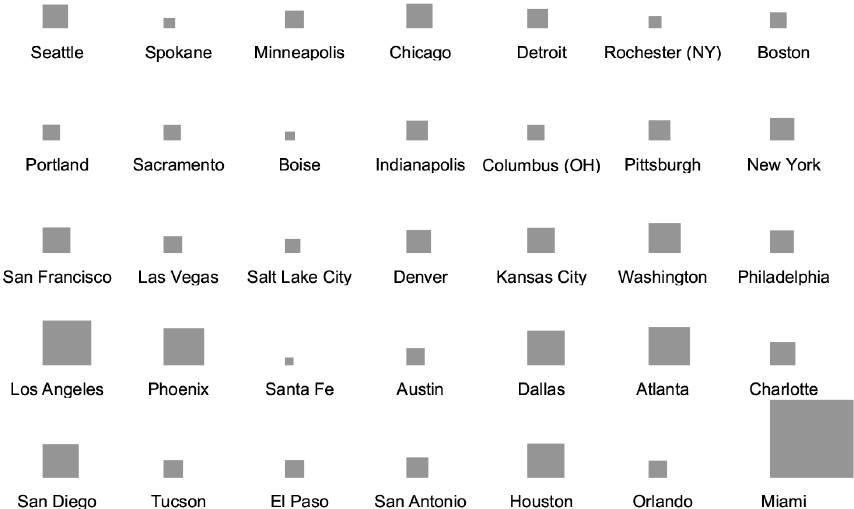
Figure B1. Size relationships between city extents shown in Fig.